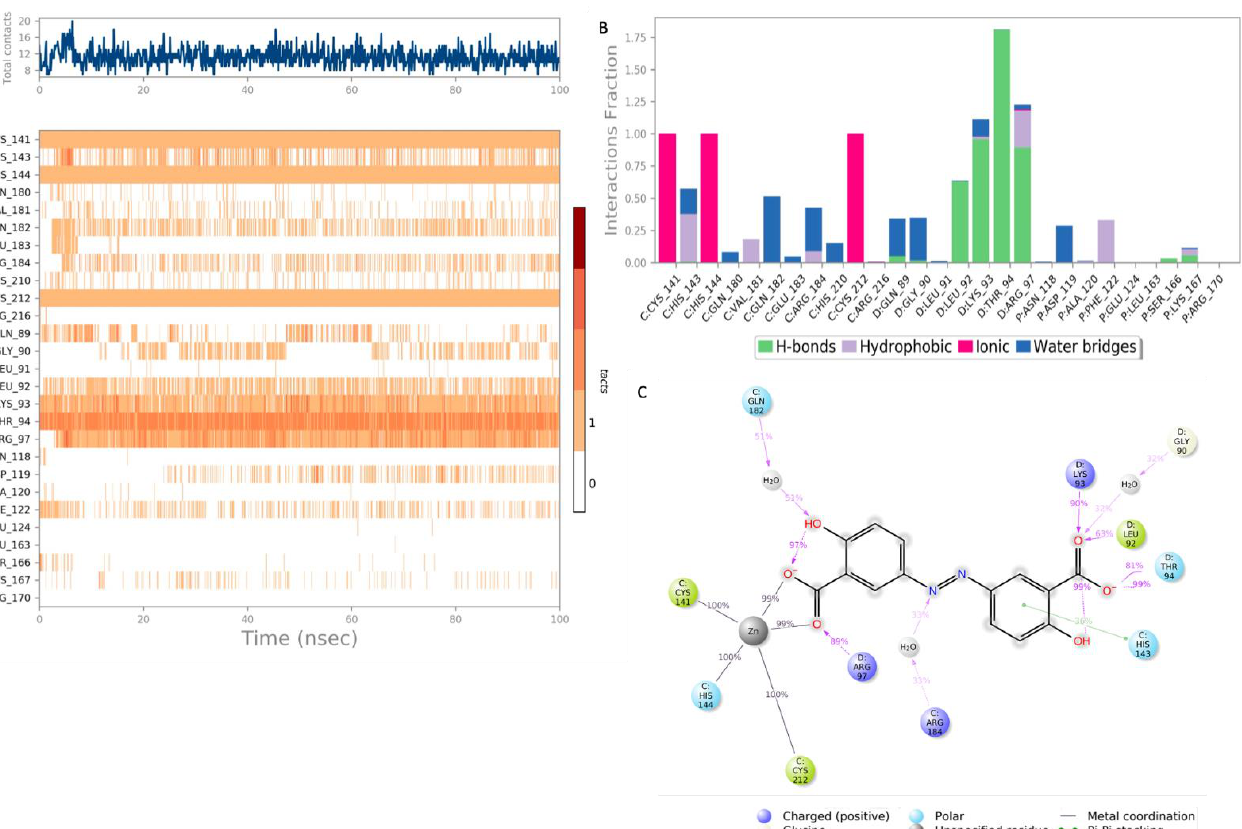
Figure 5. Interaction diagram of olsalazine with the GTPCH1 binding pocket. ( A ) Interaction of olsalazine with residues in each trajectory frame. The depth of color indicating the higher the interaction with contact residues; ( B ) the protein – ligand contacts showing the bonding interaction fractions and the nature of the interactions; ( C ) graphical 2D illustration of olsalazine interacting with the protein residues during MD simulation. Interactions shown occurred over 30% of the simulation time. C — chain C of the GTPCH1 binding pocket; D — chain D of the binding pocket.